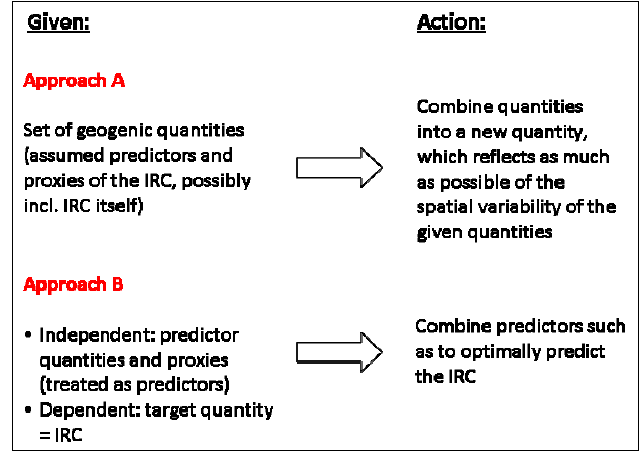
Figure 2. Approaches A and B.